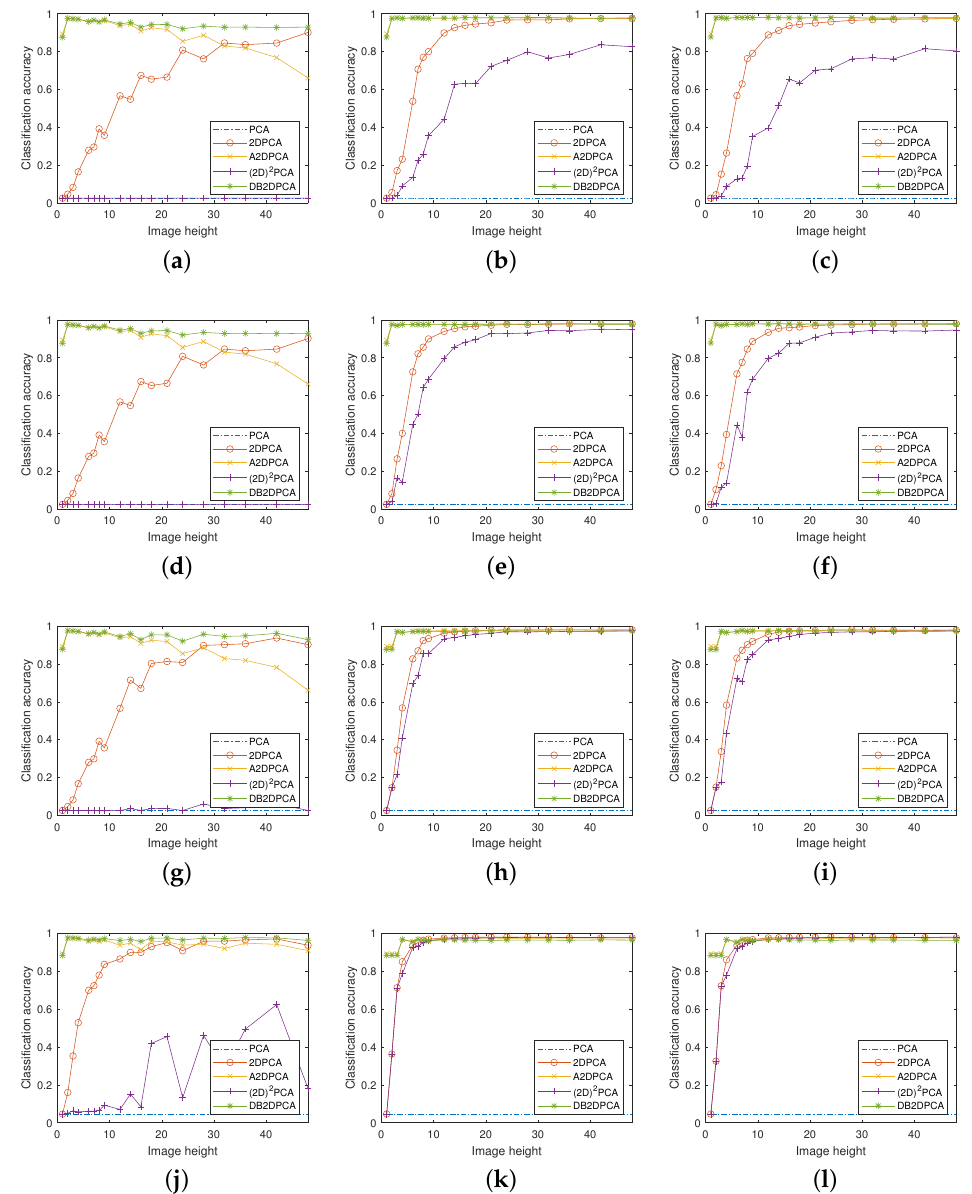
Figure 10. The average classification accuracies corresponding to four thresholds on the Extended Yale B face database and its reordered and reshaped variants with CRC as the classifier. Four rows correspond to results when the threshold θ equals 0.5, 0.6, 0.7 and 0.8 in order. Three columns corre- spond to results of variants 0–2 in order. In each subfigure ( a – l ), the five accuracy curves correspond to the five feature extraction algorithms, i.e., PCA, 2DPCA, A2DPCA, ( 2D ) 2 PCA and DB2DPCA. The experiments corresponding to the four rows in Figure 10 differ in the preset θ value. Generally speaking, the classification accuracies increase with increasing θ value; this is due to the fact that the number of extracted features increases when the percentage of total variance explained by these features—i.e., the θ value—increases. Having more features leads to better classification performance, especially when the percentage of total variance explained by these features is not large enough, e.g., smaller than 0.95. Therefore, the classification accuracies increase with increasing θ